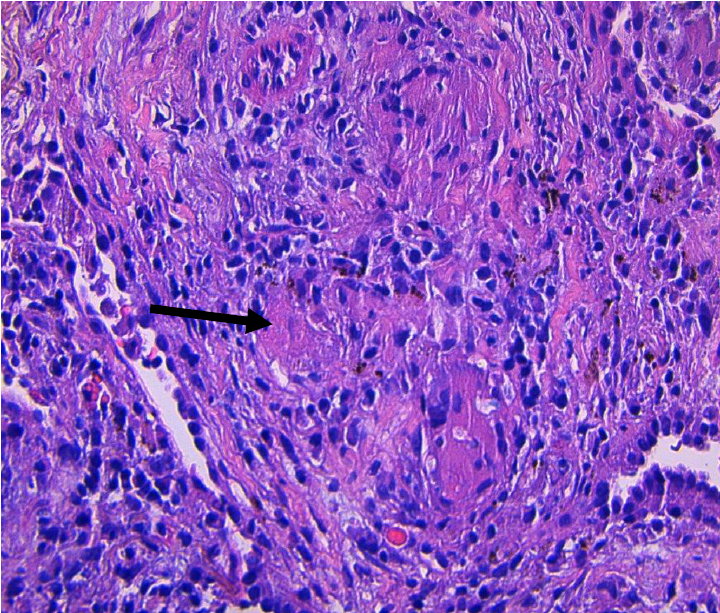
Figure 3. Non-caseating granuloma from a CT-guided biopsy of the left lung nodule showing an asteroid body (black arrow), a typical finding in granulomas.